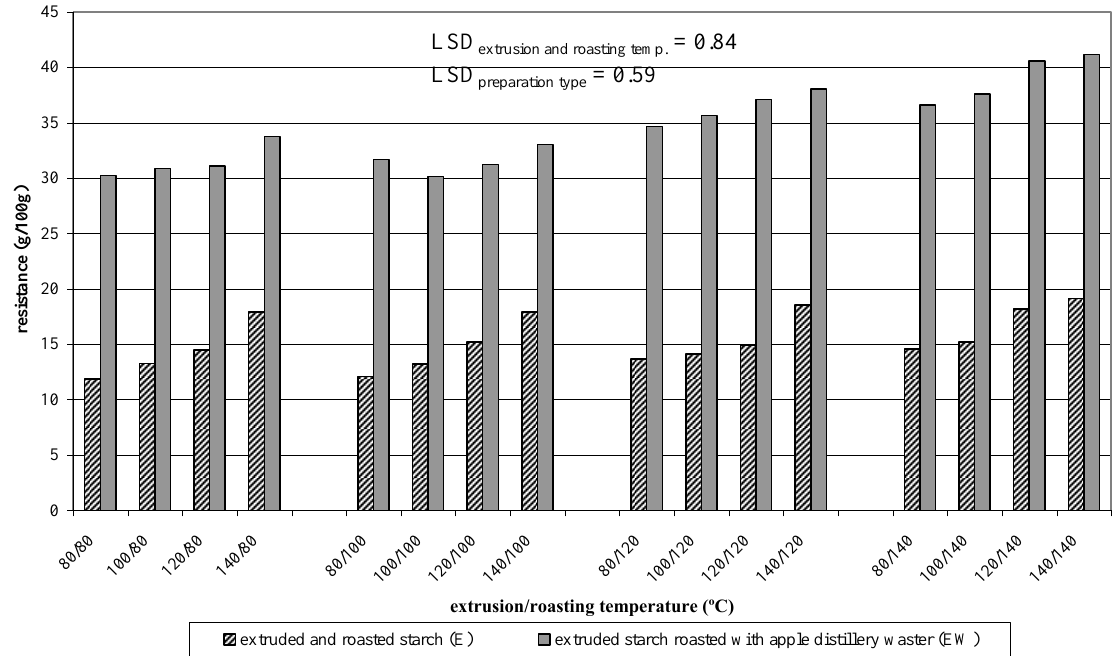
Figure 3. Resistance of extruded and roasted starch (E) and of starch extruded with apple distiller wastewater and roasted (EW) to the action of amyloglucosidase.